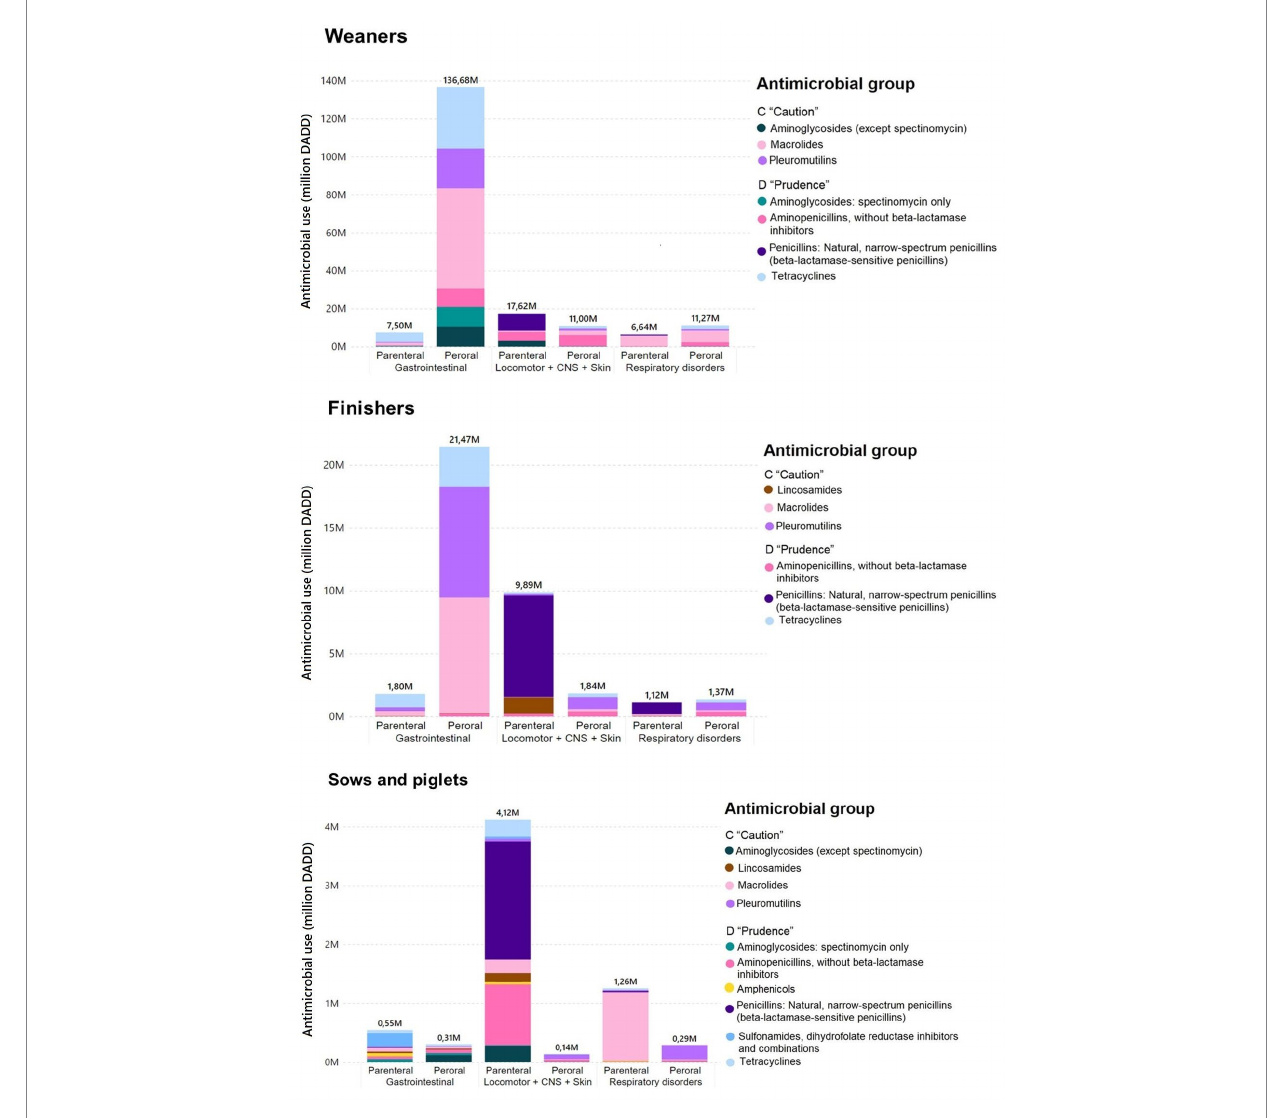
FIGURE 3 Distribution of AMU, in DADD units, in the Danish pig sector in 2020, per treatment indication, divided by AM classes, where each graph represents an age group. AM classes that constituted less than 5% of the treatments in all selected indications were excluded. Only the three most frequent treatment indications are shown. To facilitate the visualization of the antimicrobial classes consumed, 100% stacked column charts are provided in Supplementary Figure